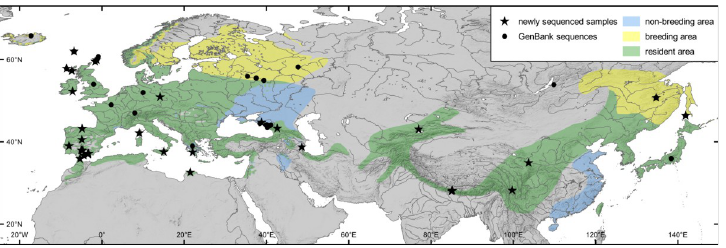
Fig 1. Distributional area of Nannus troglodytes in the Palearctic. Seasonal ranges indicated by colour (green: whole-year resident; yellow: breeding; blue: non-breeding; data from [56]), and genetic sampling localities for our phylogenetic analyses indicated by symbols (stars: newly sequenced samples for this study; circles: sequences retrieved from GenBank).